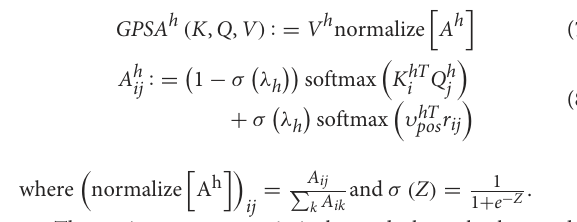
caused by hard induction bias of CNN and the high dependence of Transformer on data. In the paper, the gated positional self- attention (GPSA) is employed to balance convolution and self- attention (SA) in a soft way, and its framework is shown in Figure 3. ConViT is based on vision transformer and consists of twelve propagation blocks composed of a SA layer and a two-layer feedforward network (FFN) with Gelu activation (see Figure 3). The difference is that the SA layer in the first ten blocks is replaced by GPSA layer, and the settings of SA layer are still retained in the last two blocks. In addition, the L2 regularization and dropout mechanism are applied in FNN to counter overfitting. Since the ECG spectrum is relatively simple, we set the input image with the size of 160 to 8 x 8 non- overlapping blocks of 20 x 20 pixels, and the embedding matrix dimension is 12.